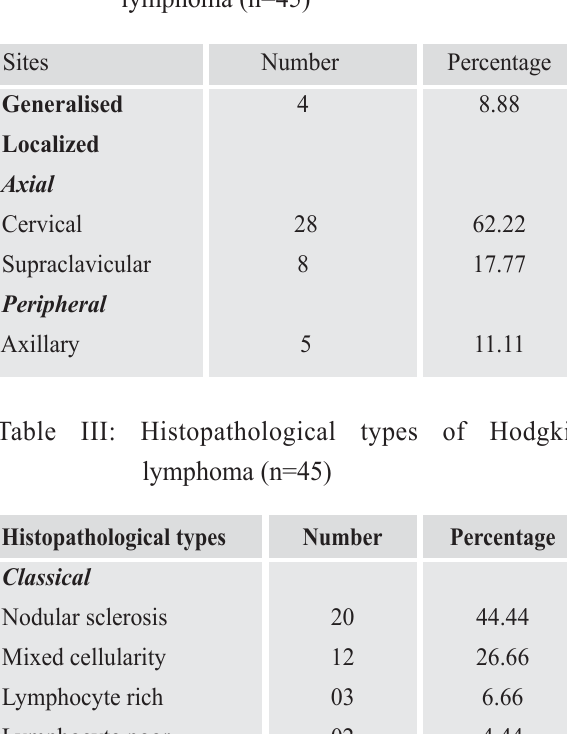
Table II: Sites of lymphadenopathy of Hodgkin